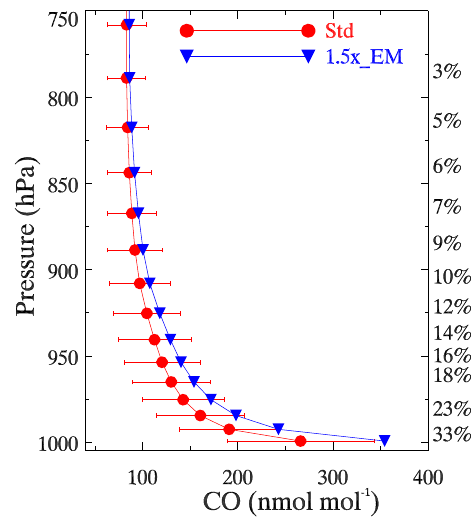
Figure 10. Monthly average vertical profile of CO over Chennai during June from Std and 1 . 5 × _EM simulations. The resulting en- hancement in CO is also indicated in percentages along the right